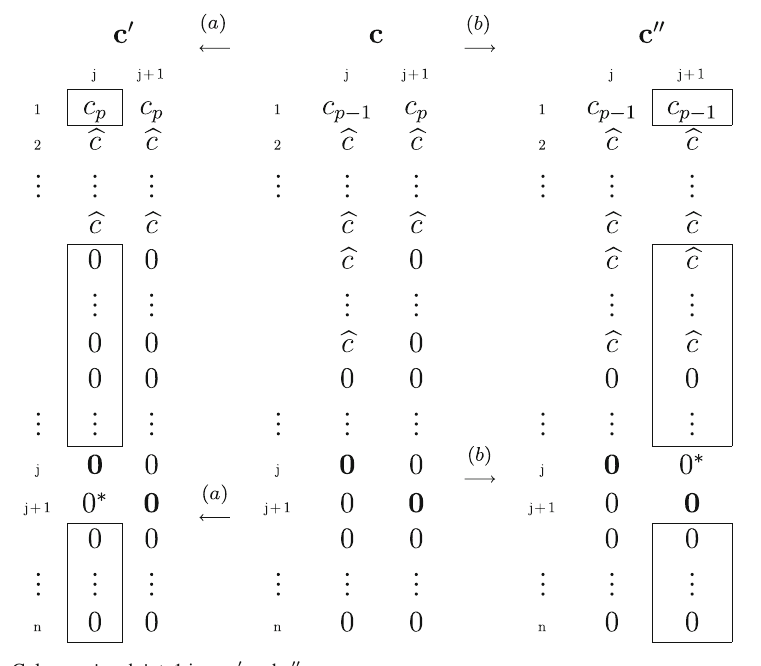
Fig. 8 Columns j and j + 1 in c , c (cid:10) and c